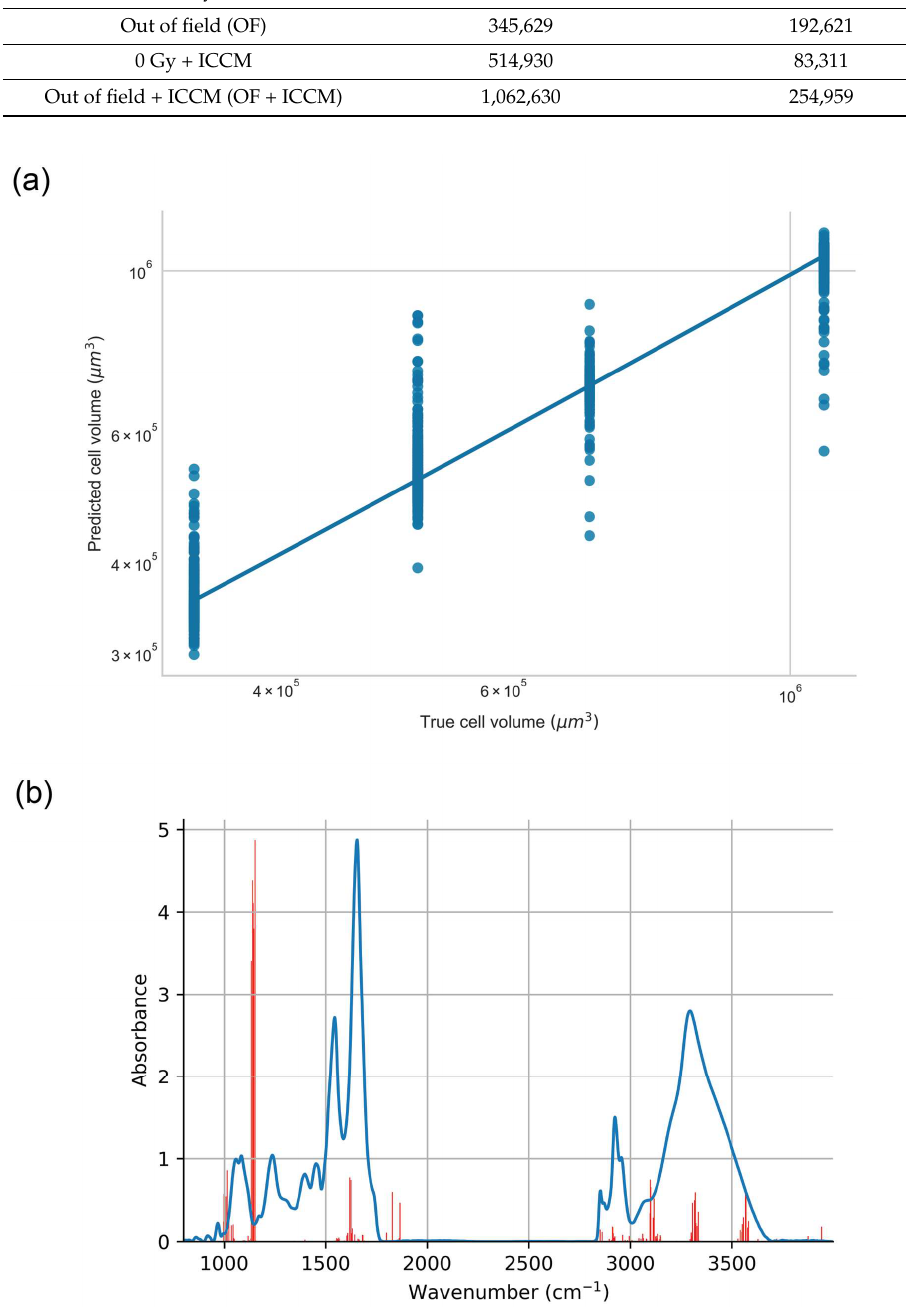
Figure 7. XGBoost regression of IR spectra from PNT1A cell line against cell volume. ( a ) Association between spectral data and cell volume. ( b ) Frequency with which spectral features (highlighted in red) are selected by XGBoost model in regression against cell volume.